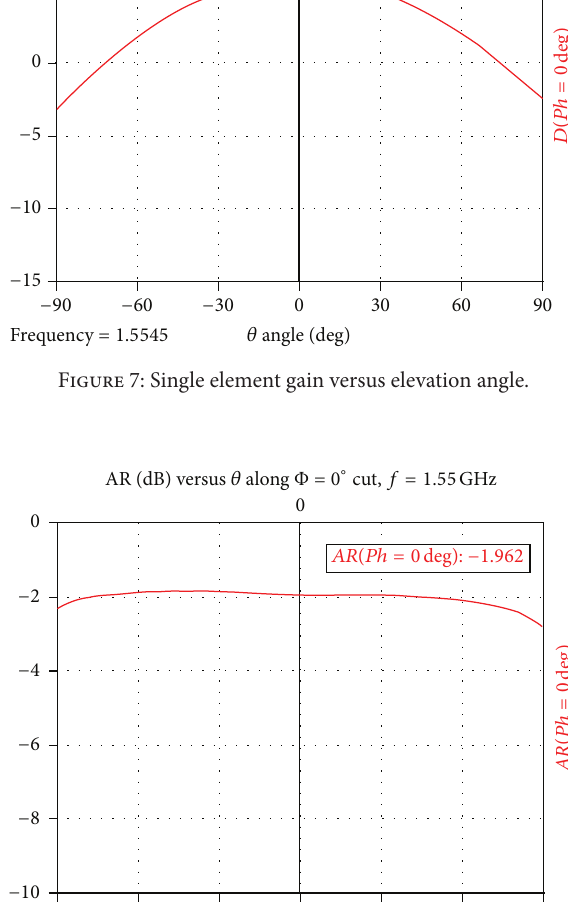
Figure 11: 7 elements array adaptive beam-forming antenna pattern—two nulls